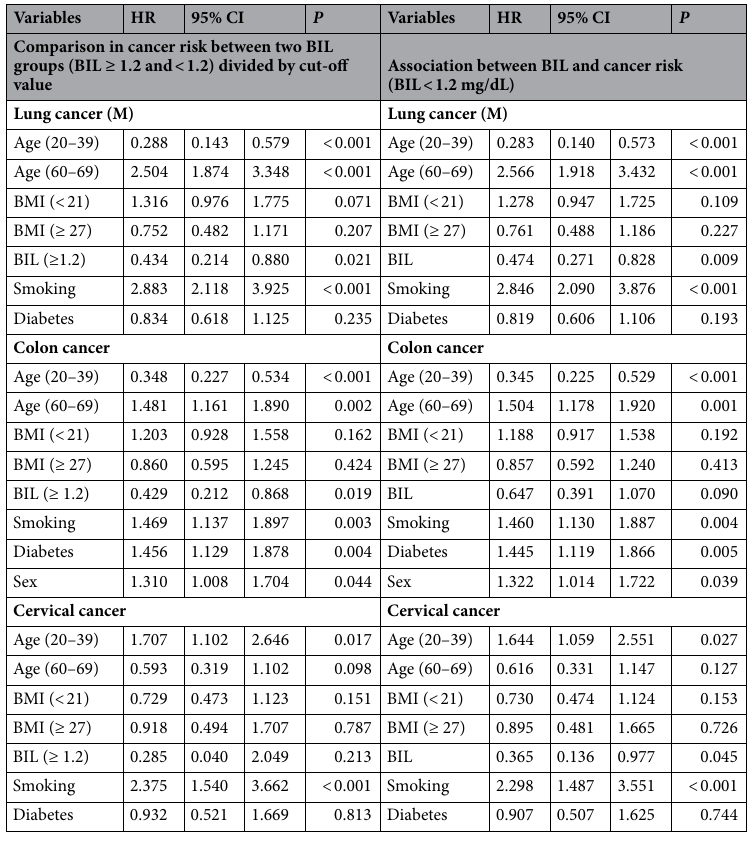
Table 2. The associations between serum bilirubin levels and each cancer risk (lung in men, colon, and Cervical). For lung cancer in men (M), colon cancer, and cervical cancer, the association between and cancer risk was evaluated by Cox hazard regression models. (Left table) First, serum bilirubin levels were divided into two groups using the cut-off value (1.2 mg/dL). The reference group for serum bilirubin levels was that of < 1.2 mg/dL. BIL (≥ 1.2), subjects with bilirubin levels ≥ 1.2 mg/dL. (Right table) Next, for serum bilirubin levels < 1.2 mg/dl, they were used as continuous variables (BIL), and the association between bilirubin